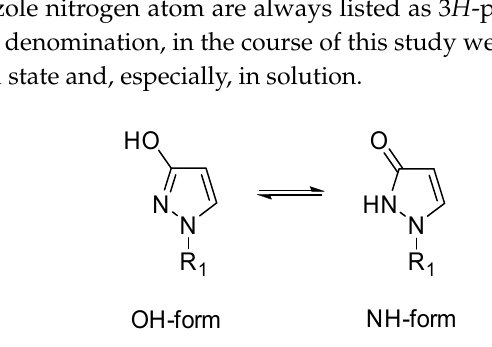
Figure 1. Possible tautomeric forms of 1-substituted 3-hydroxy-1 H -pyrazoles (1-substituted 1,2-dihydro- 3 H -pyrazol-3-ones).